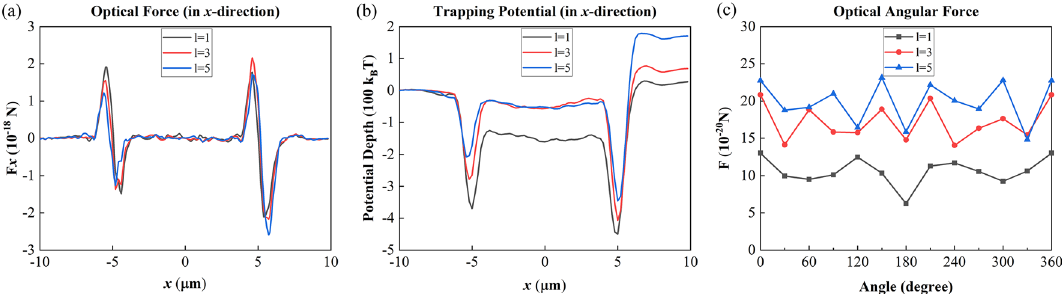
Figure 4. The force distributions when l equals 1, 3, 5. ( a ) The optical force along the x -direction; ( b ) The trapping potential along the x -direction; ( c ) The angular optical force of metallic particle every 30 degrees along the focal ring of Q-PV.